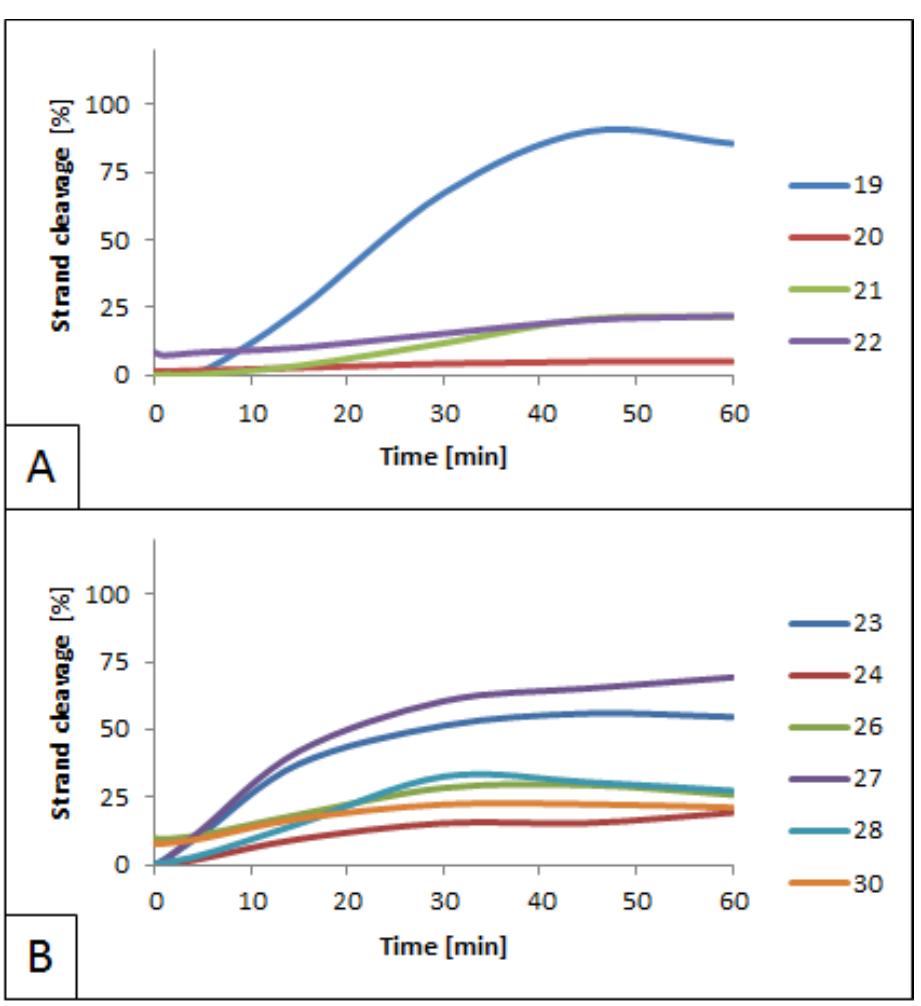
Figure 5. Cleavage of dsDNA containing ScdG and RcdG by 0.5 U BsmAI. ( A ) Quantity increase of cleaved strands 19–22. These strands are arranged in duplexes J and K, which contain cdG lesions located within the cleavage site of BsmAI (Figure 2). ( B ) Quantity increase of cleaved strands 23–24, 26–28, and 30. These strands are arranged in duplexes L–O, which contain double-stranded lesions—cdPus are located on both strands, within the recognition sites of both enzymes (Figure